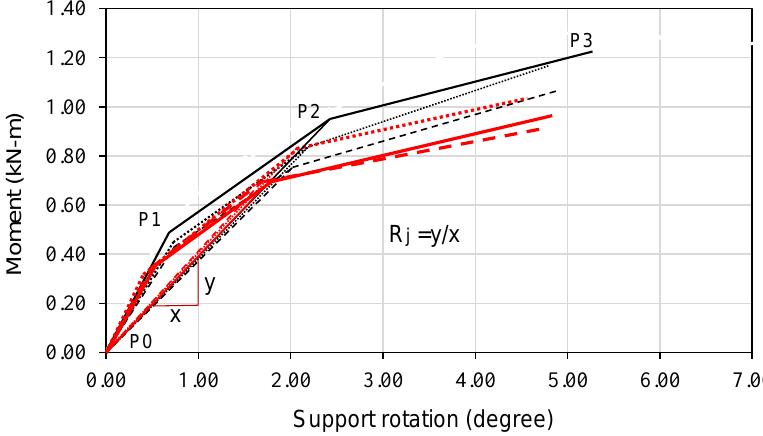
Figure 4. The simplified tri-linear moment rotation curves of connections.